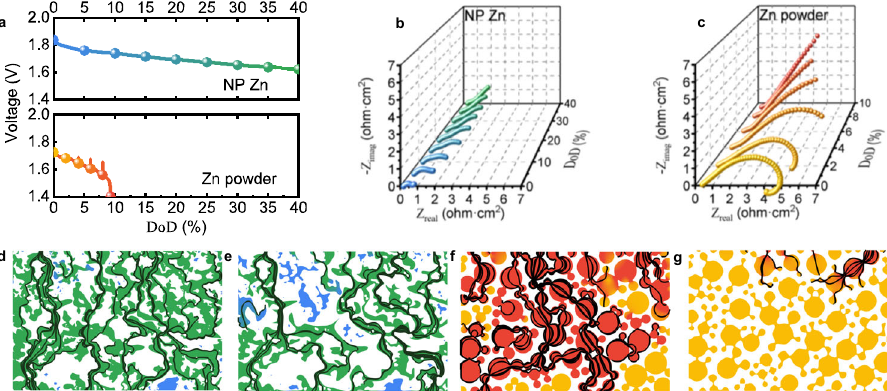
Fig. 4 Electrochemical characterization and image-based simulation of the two different zinc metal electrodes. a Discharge curves of NP Zn and Zn powder at 5 mA/cm 2 . At the increments of 5% and 2% for the NP Zn and the Zn powder anodes (shown as solid circles), EIS was recorded and shown in b and c in the form of Nyquist plots respectively. Image-based simulations of NP Zn with d 0 erosion and e 40% erosion, and Zn powder with f 0 erosion and g 40% erosion. The green and red areas in d , e and f , g respectively are of high local current when a voltage difference is applied to the top and bottom of the images, whereas the blue and orange areas are of no local current. The current pathways are highlighted in DoD ’ s, corresponds to the average distance between two black pixels (the Zn phase in the binary image) in a cluster of connected black pixels (i.e., a connected structure of Zn). The same drop in ξ ’ does not happen to the NP Zn until 60% DoD, highlighting its strongly correlated, stable Zn structures.